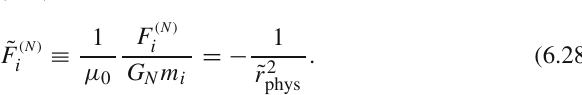
Fig. 3 Graphical representations of the gravitational potentials (top) definedbyEqs.(6.25),(6.26)andforces(bottom)definedbyEqs.(6.27),